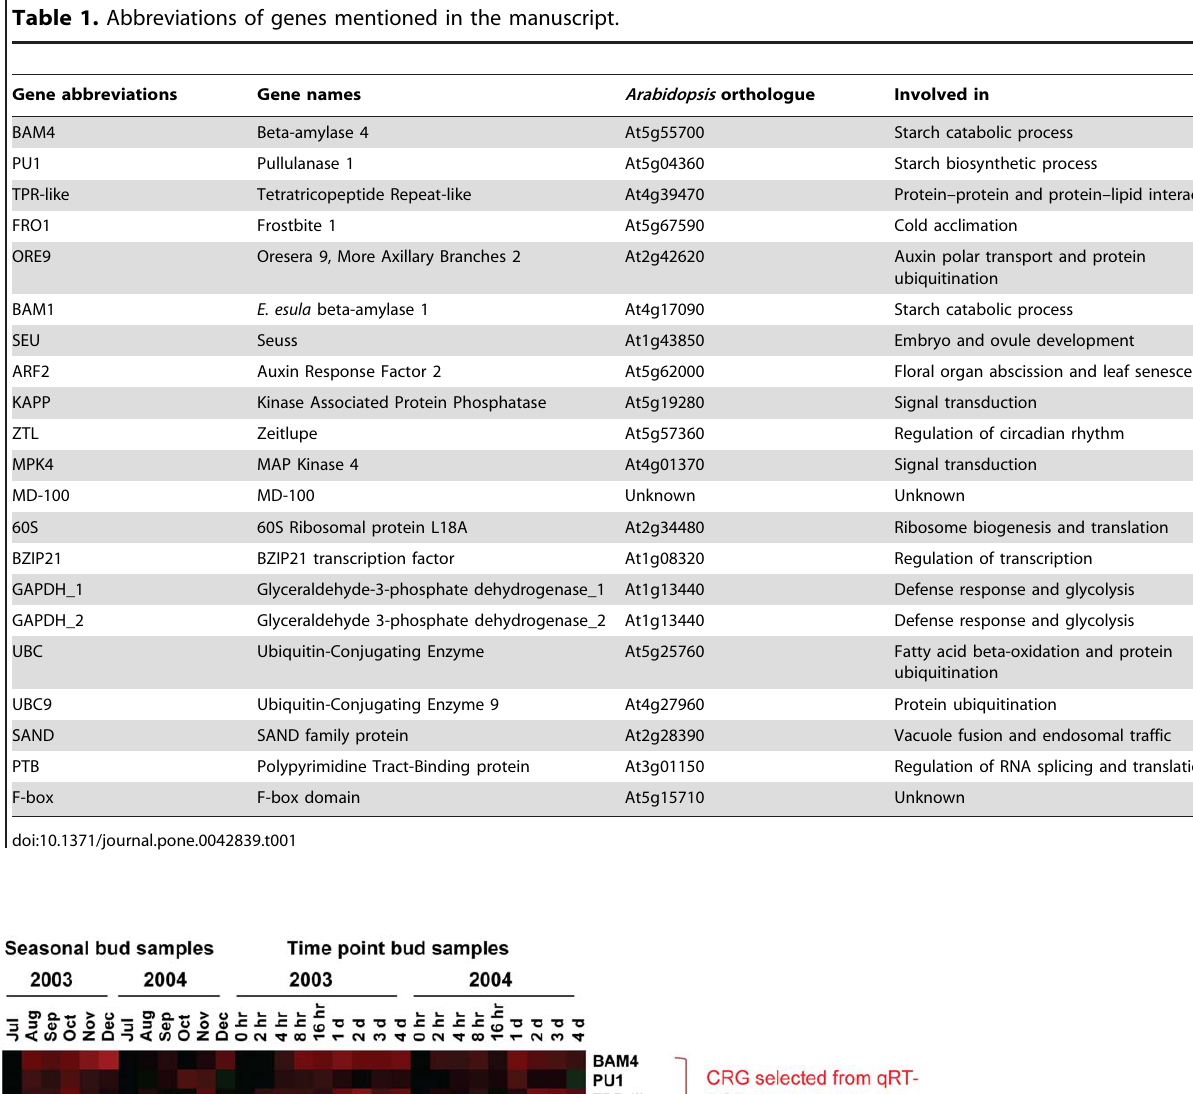
Table 1. Abbreviations of genes mentioned in the manuscript.